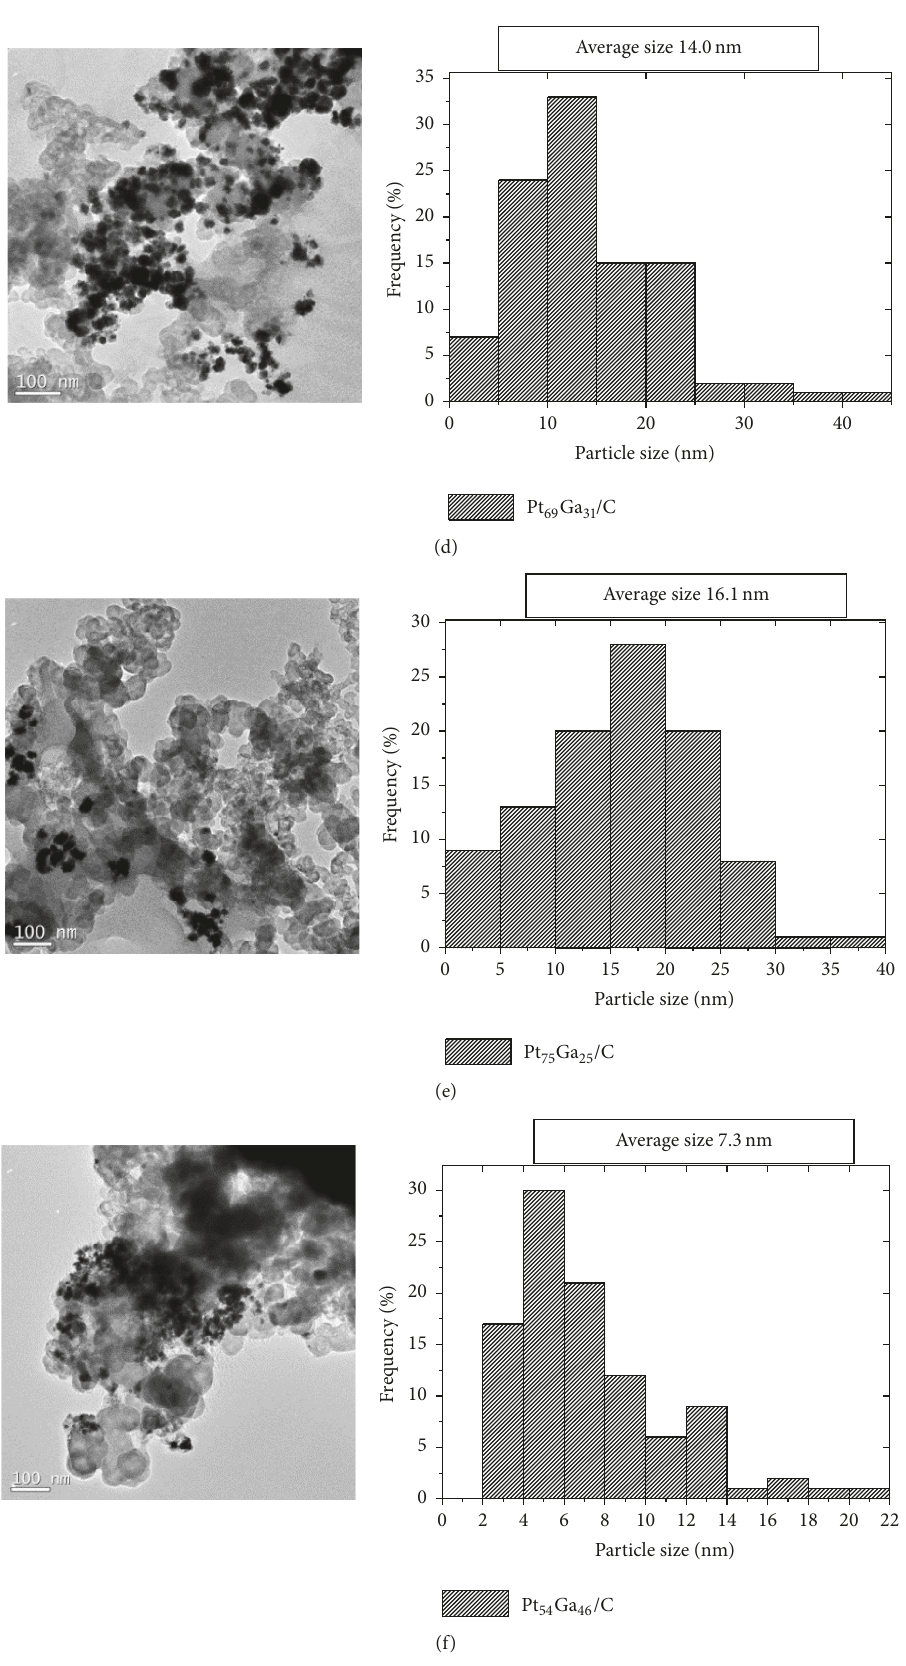
Figure 4: TEM images by side of particle size distribution of the PGa/C catalysts: (a) Pt 100 /C, (b) Pt 91 Ga 9 /C, (c) Pt 83 Ga 17 /C, (d) Pt 69 Ga 31 /C, (e) Pt 75 Ga 25 /C, and (f) Pt 54 Ga 46